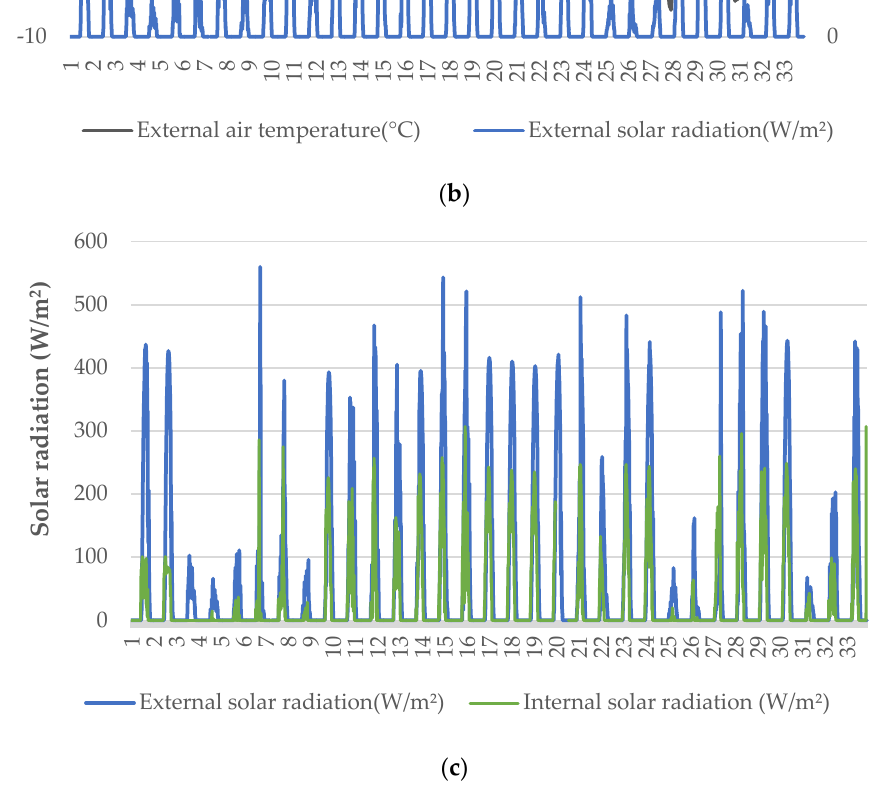
Figure 1. Microclimatic data ( a ), external weather conditions ( b ), and solar radiation ( c ) during the cultivation period.